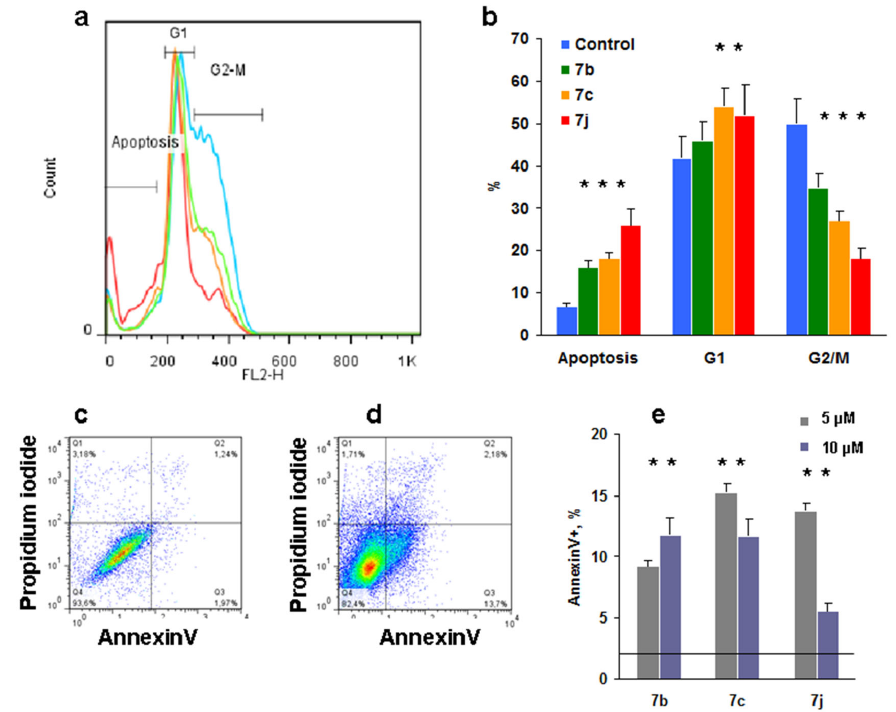
Figure 6. Mechanisms of cell death induced by the compounds 7. ( a , b ) Representative data on the cell cycle of SkBr-3 cells after 24 h incubation with 10 µ M of 7b (green), 7c (orange), and 7j (red). Control cells are shown in blue color. ( c – e ) Apoptosis of SkBr-3 cells: ( c ) control cells, ( d ) cells incubated with 7c for 24 h cells. ( e ) Apoptosis induction level for 7b , c , j at 5 µ M (gray) and 10 µ M (violet). Apoptosis level in control cells is shown with a black line. Statistical significance is shown by asterisks.